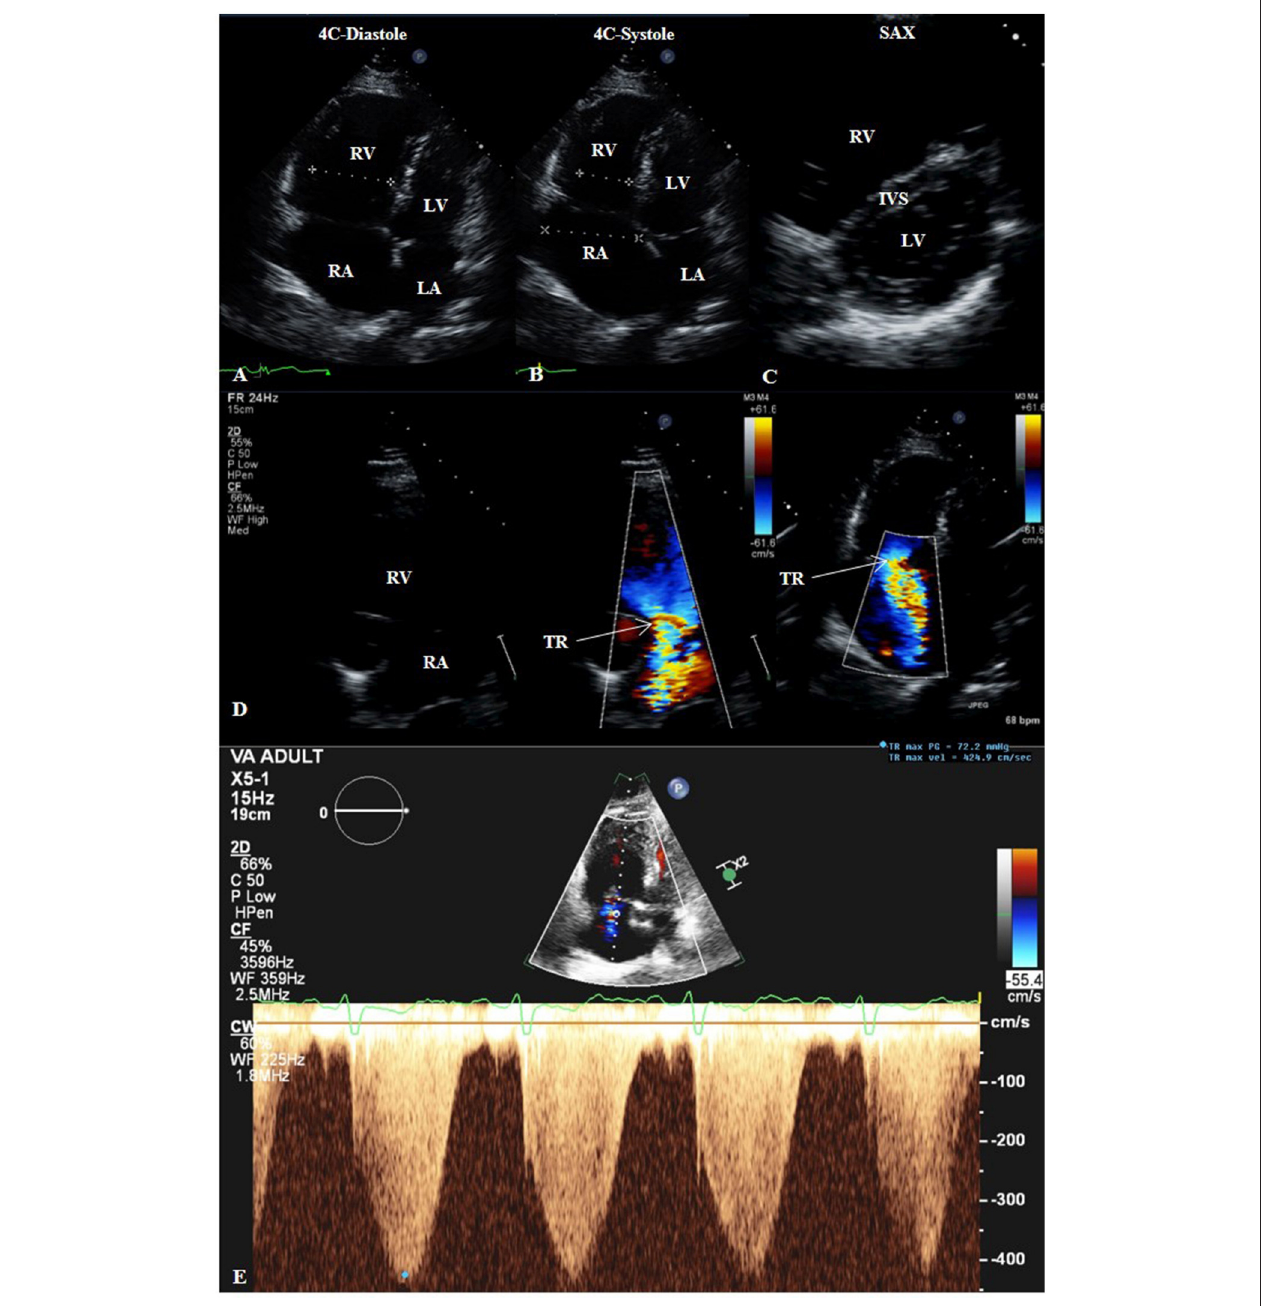
FIGURE 4 | Transthoracic echocardiogram (TTE) of a patient with groups 2 and 3 pulmonary hypertension. 2D TTE in the apical four-chamber (4C) view in diastole (A) and systole (B) showing right heart dilatation. 2D TTE in the short-axis (SAX) view (C) showing flattening of the interventricular septum compatible with the right heart findings. (D) Color-compare TTE in the right ventricular inflow view and color Doppler TTE in the 4C view showing severe tricuspid regurgitation. (E) Continuous-wave Doppler TTE showing maximum trans-tricuspid valvular regurgitant jet velocity of 4.25 m/s, correlating to estimated pulmonary artery systolic pressure of 72 mmHg plus right atrial pressure. 4C, four-chamber; IVS, interventricular septum; LA, left atrium; LV, left ventricle; RA, right atrium; RV, right ventricle; SAX, short-axis; TR, tricuspid regurgitation.